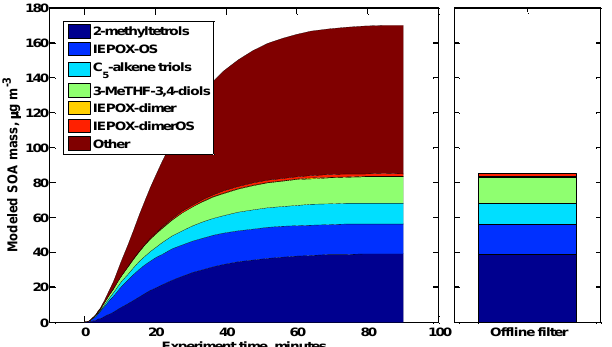
Figure 3. Model output of IEPOX-SOA tracers (left panel) and the associated filter-based tracer measurements (right panel) for Exp. no. 1. The “other SOA” is calculated as the difference be- tween the chamber-measured aerosol mass loadings and the sum of the filter-based tracer loadings.